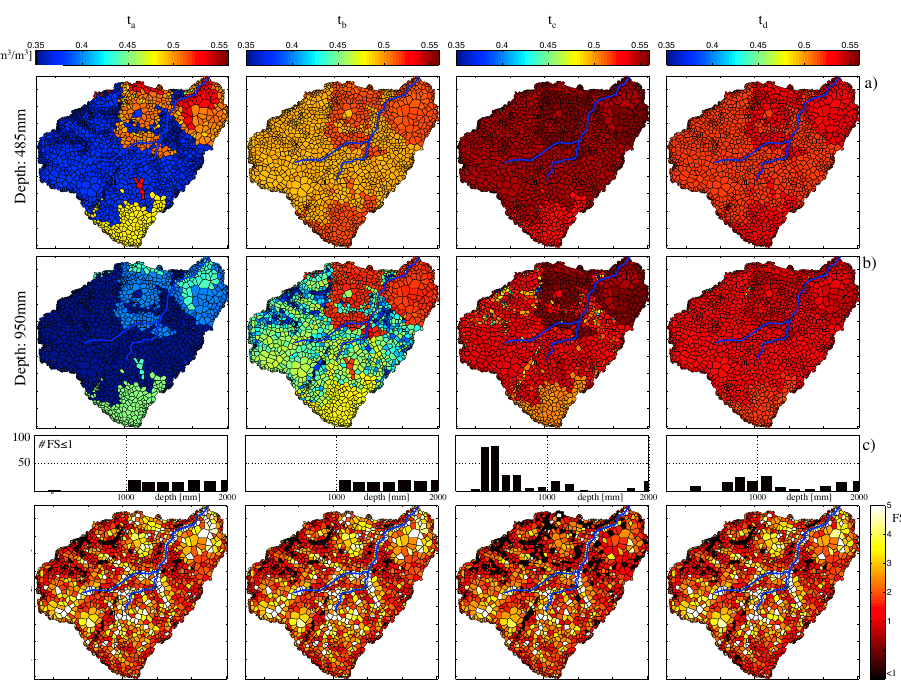
Fig. 7. Spatial distribution at selected time steps (from left to right: t a , t b , t c and t d ) for anisotropy equal to 1: soil moisture at depths 485mm (a) and 950mm (b) , and FS distribution obtained either as the minimum value along the vertical profile or as the first depth where FS ≤ 1 (c) .